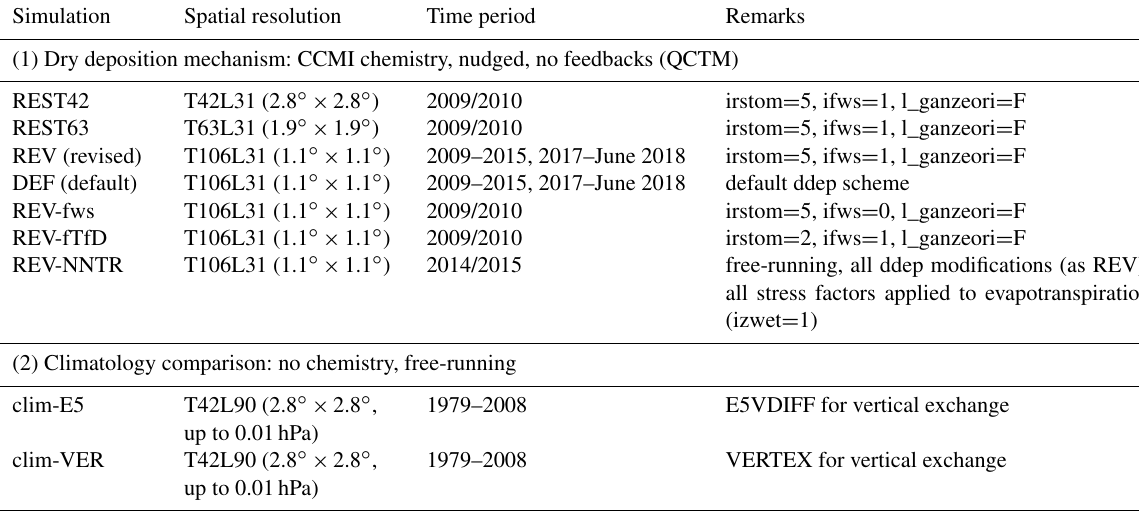
Table 1. List of EMAC simulations Simulation Spatial resolution Time period